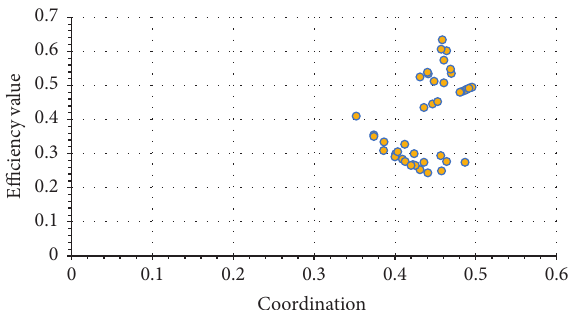
Figure 9: Coordination and efficiency matrix of urban agglomerations in Northwest China.